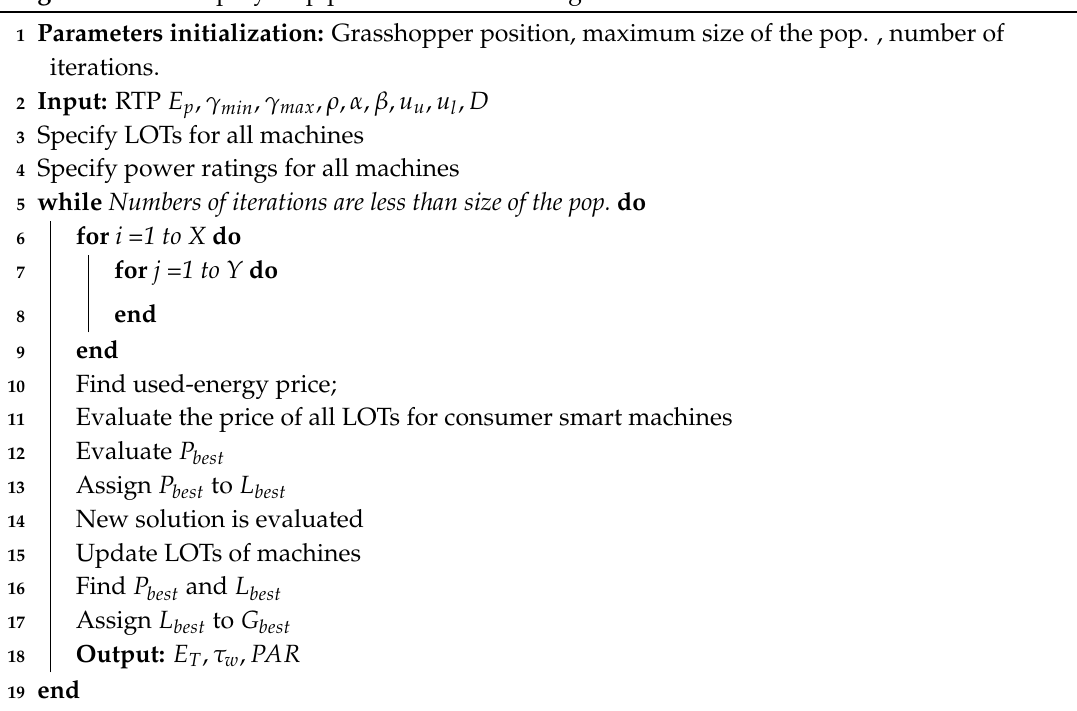
Algorithm 1: A step-by-step process of the GOA